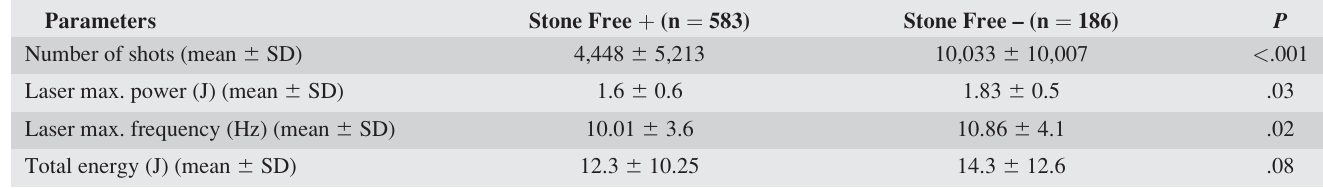
Table 3. Details of the Relationship between Stone-Free þ and – Groups and Laser Parameters Parameters